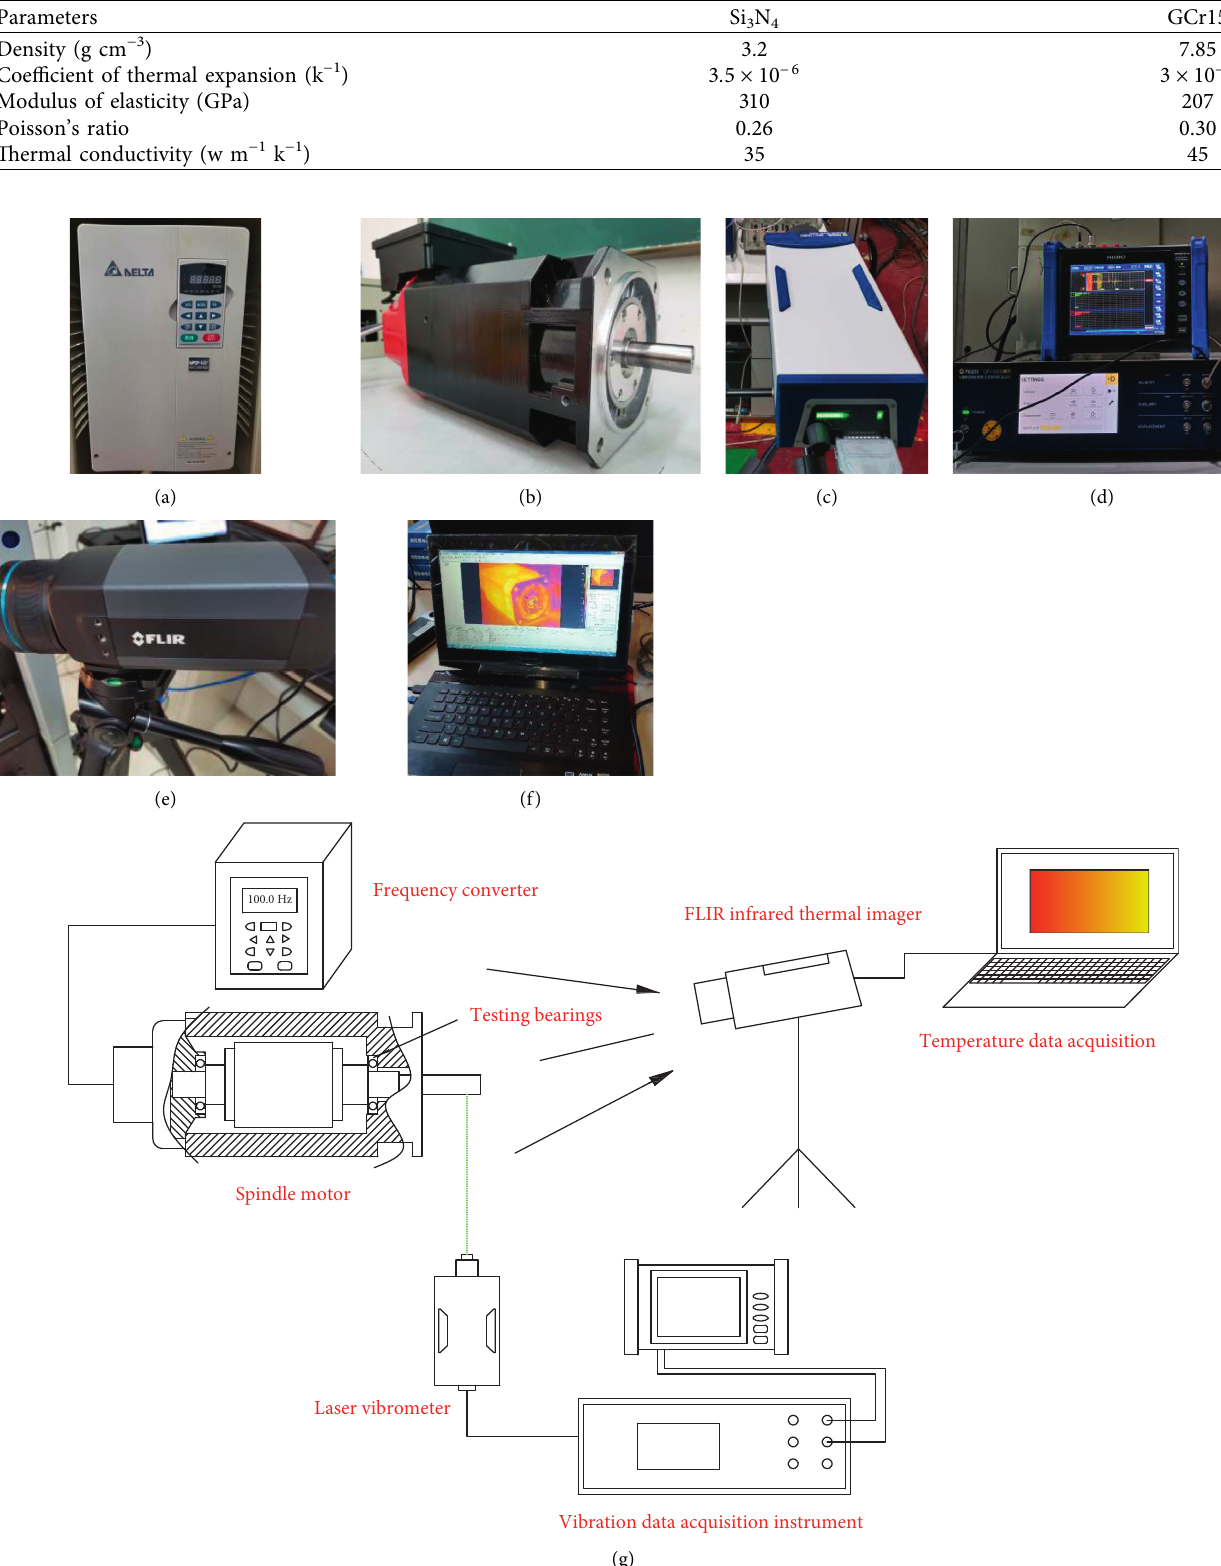
Figure 4: Experimental devices and schematic diagram: (a) Frequency converter. (b) Spindle motor. (c) Laser vibrometer. (d) Vibration data acquisition instrument. (e) Infrared thermal imager. (f) Temperature data acquisition. (g) Experimental schematic